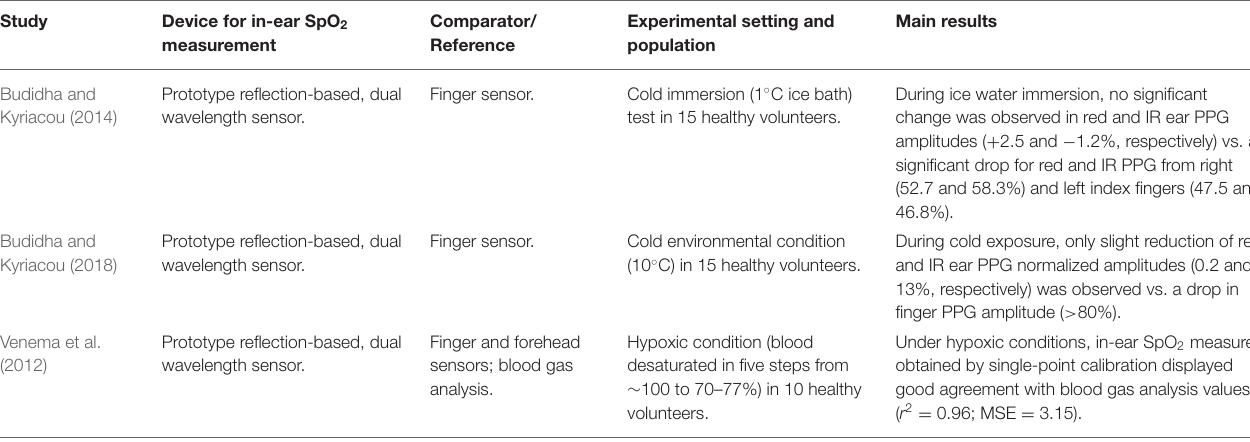
Comparator/ Experimental setting and Reference